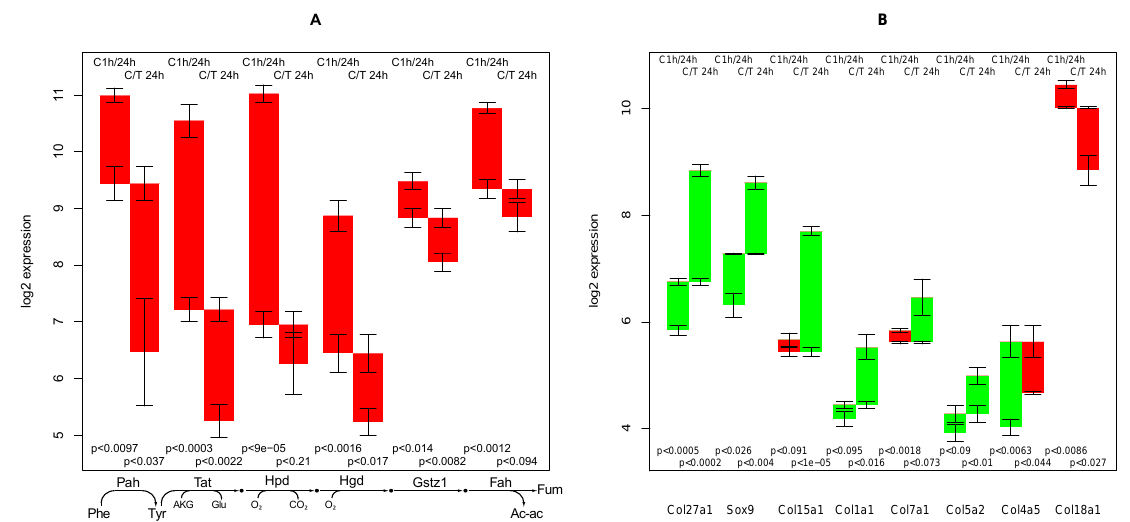
Figure 2. (A) Regulation of the degradation cascade of phenylalanine and tyrosine; (B) Regulation of selected collagens and a promoter. Red bars indicate down-regulation and green bars indicate up-regulation. Either 2 time points in the control experiment (e.g., C1h/24 h) or the same time point of control vs. TGF β treated sample (e.g., C/T 24 h) are compared. Error bars indicate average standard deviation of 3 independent experiments. P-values refer to the probability that there is equal expression of two respective probe values, as determined with the Welch’s t test [18] in 3 independent